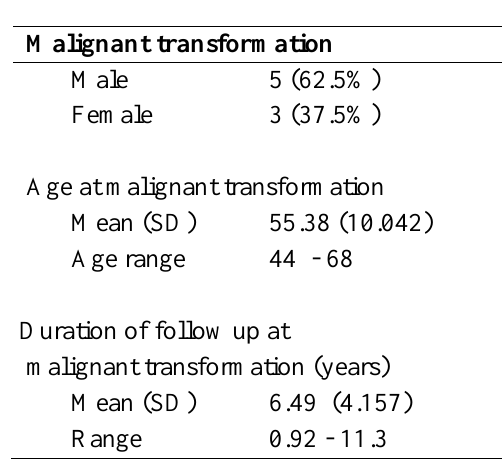
Age at malignant transformation